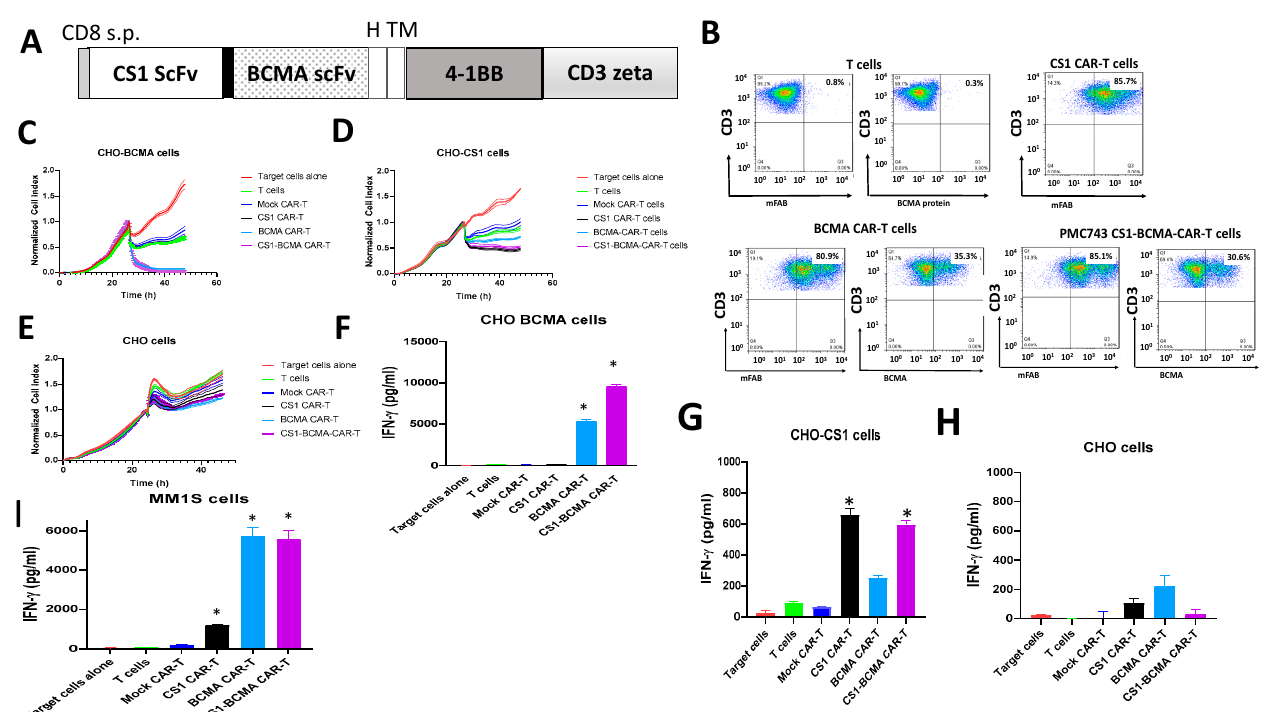
Figure 3. Bispecific CS1-BCMA CAR-T cells specifically target CS1-positive and BCMA-positive target cells. ( A ) Structure of bispecific CS1-BCMA-CAR-T cells. s.p., signaling peptide; H, CD8 hinge; TM-CD28 transmembrane domain; 41BB costimulatory domain; CD3 activation domain. ( B ) Bispecific CS1-BCMA CAR-T cells expressed both ScFvs as detected by